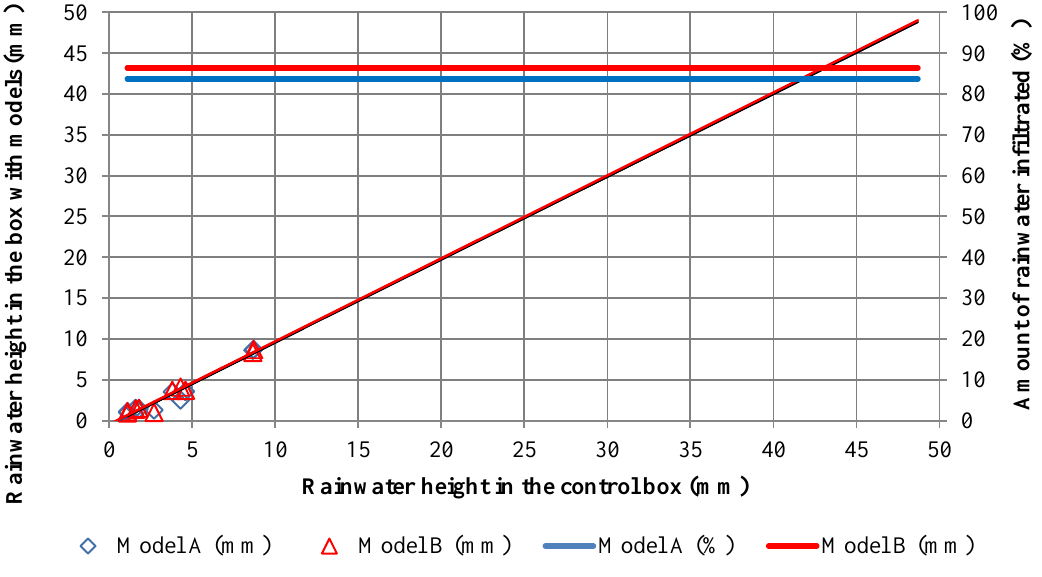
Figure 6. Amount of rainwater infiltrated through models A and B.